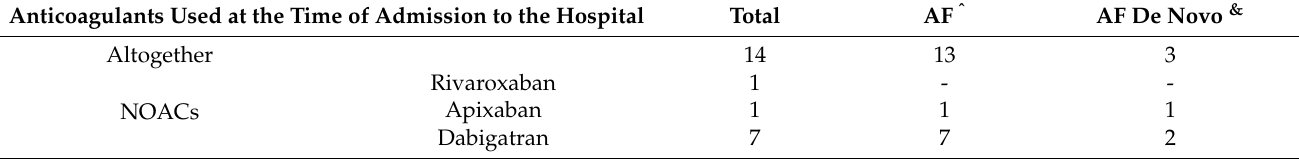
Table 2. Anticoagulants used at the time of admission to the hospital. Anticoagulants Used at the Time of Admission to the